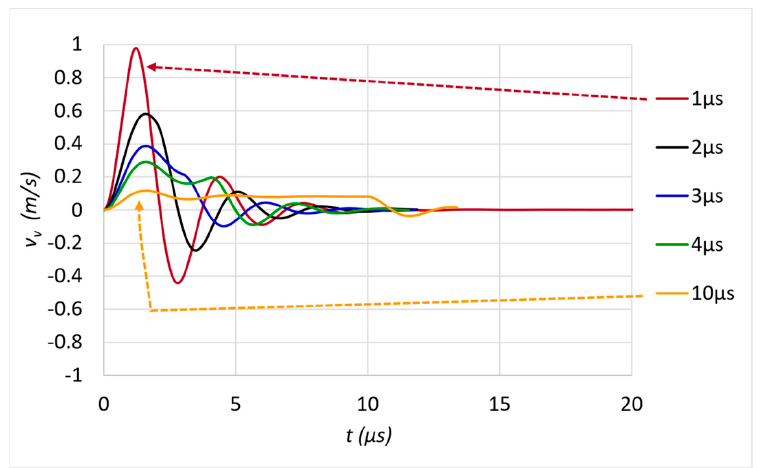
Figure 11. Estimated transient vibration velocities for different slip times calculated using the thickness mode force factor of the actual multilayer actuator and geometric parameter of the stator.